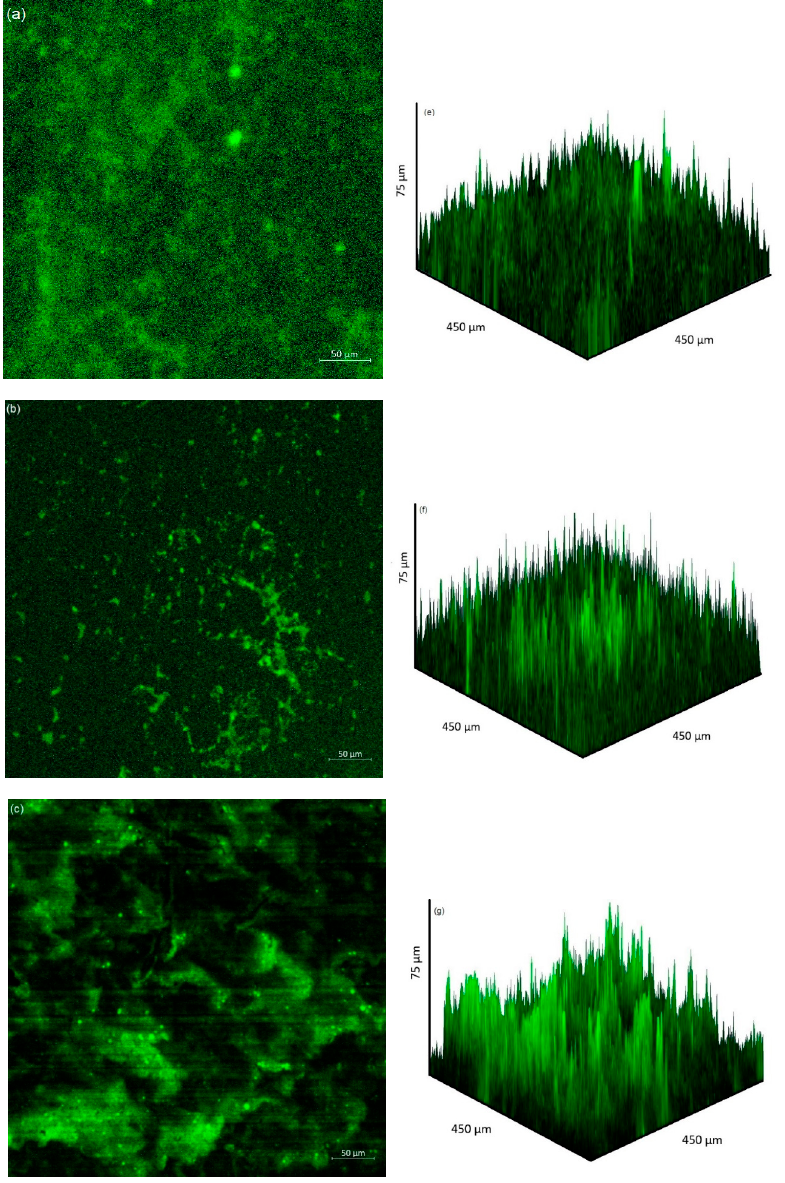
Figure 3. The change in pH over time for samples at different starting pH. Appl. Sci. 2020 , 10 , x FOR PEER REVIEW